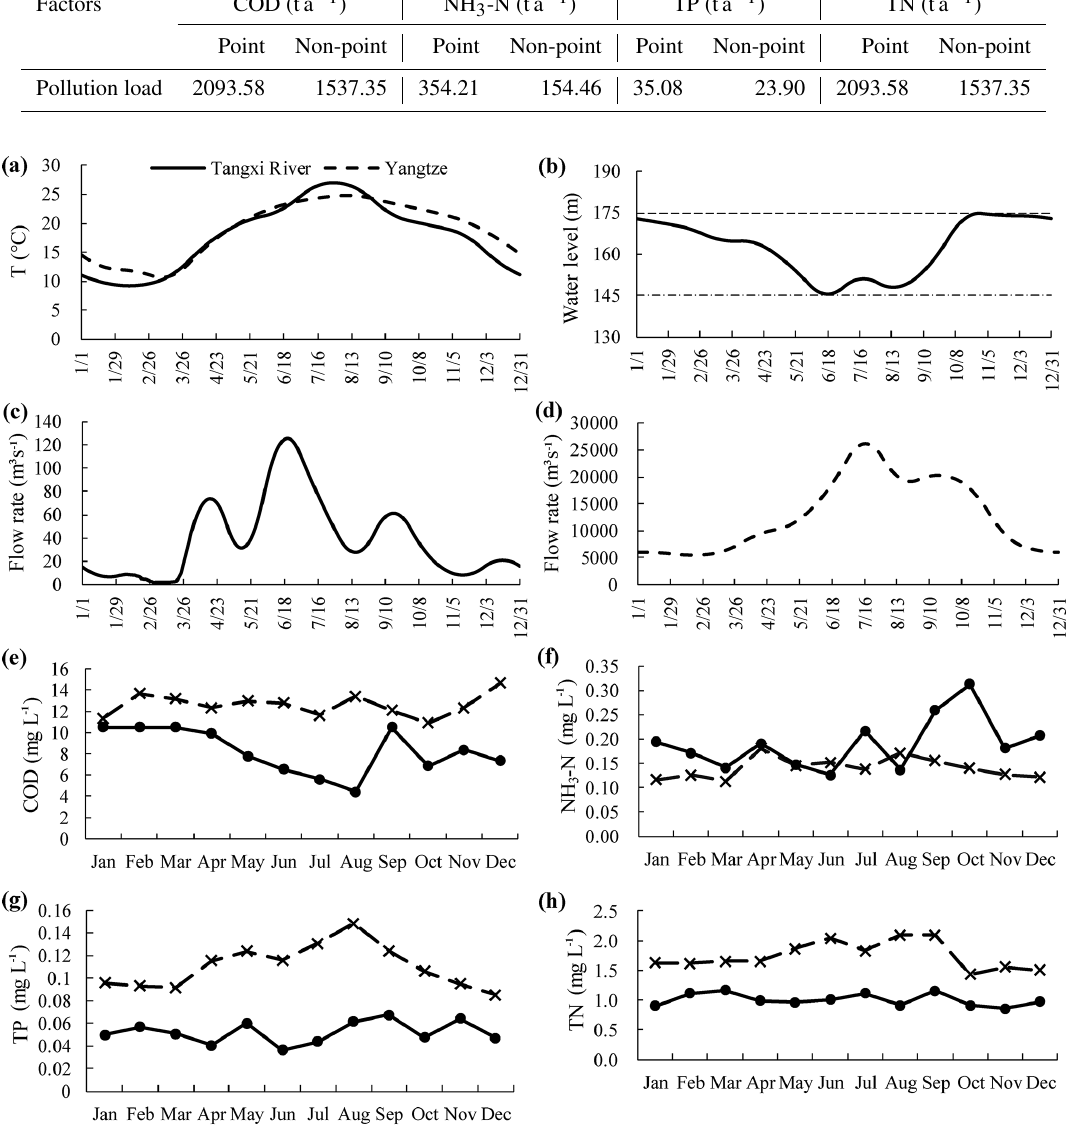
Table 1. Statistics of pollution load in the Tangxi River research area.